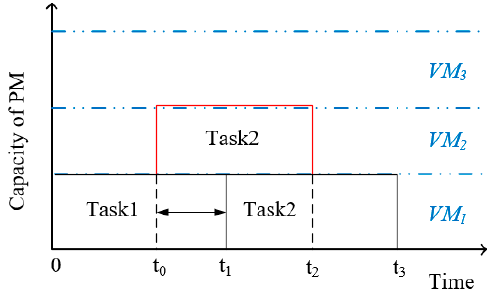
Figure 2. Waiting time for offloaded tasks.